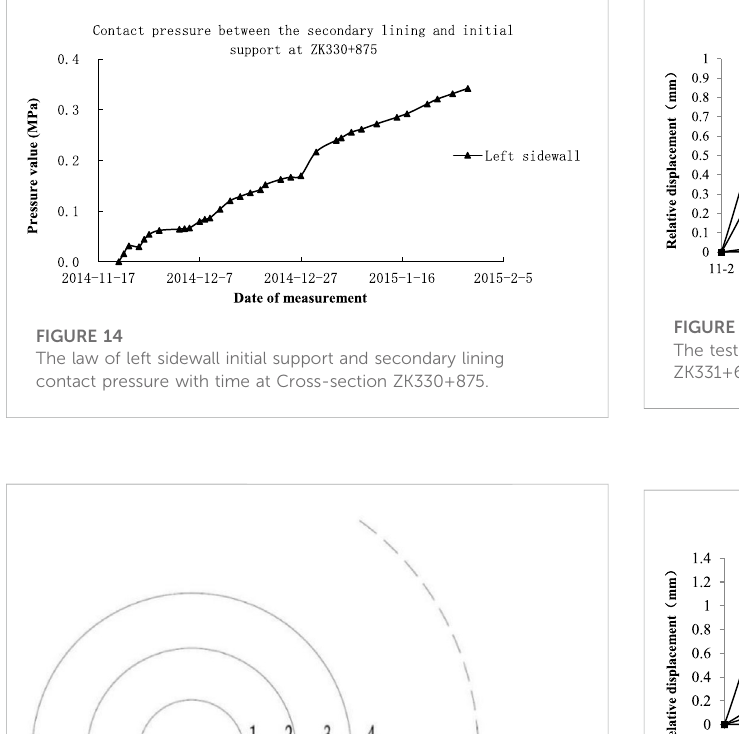
FIGURE 17 The test results of Measuring point 1 at Cross-section ZK331+625 by multipoint displacement meter